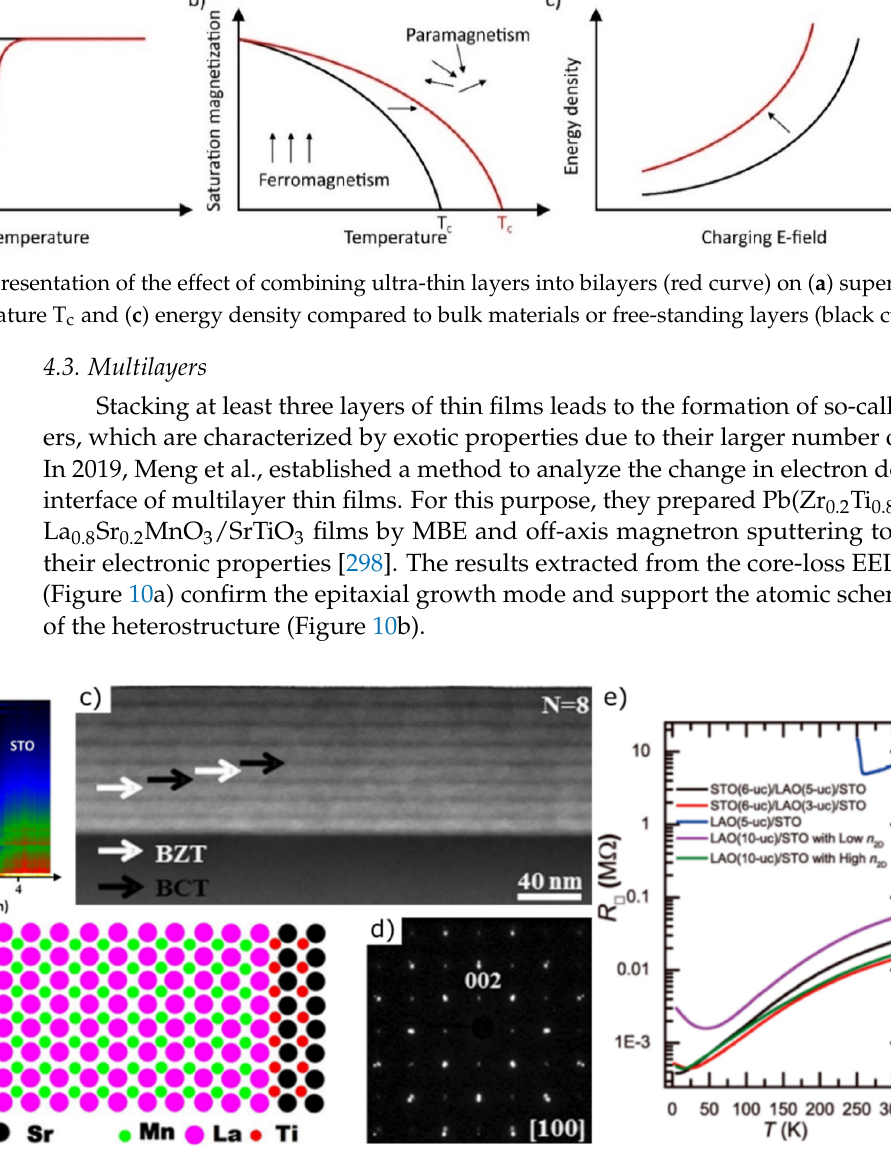
Figure 10. ( a ) Core-loss EELS spectrum image of Ti L, O K, Mn L and La M edge and ( b ) atomic schematic model of a Pb(Zr 0.2 Ti 0.8 )O 3 /La 0.8 Sr 0.2 MnO 3 /SrTiO 3 structure [298]. ( c ) Cross-sectional STEM image and ( d ) SAED pattern of a (Ba 0.7 Ca 0.3 TiO 3 /BaZr 0.2 Ti 0.8 O 3 ) 4 multilayer. Black and white arrows indicate Ba 0.7 Ca 0.3 TiO 3 (BCT) and BaZr 0.2 Ti 0.8 O 3 (BZT), respectively [299]. ( e ) Temperature-dependent sheet resistance R S for LaAlO 3 (5-uc)/SrTiO 3 (100), LaAlO 3 (10- uc)/SrTiO 3 (100), and SrTiO 3 (6-uc)/LaAlO 3 (t-uc)/SrTiO 3 (100). Samples with the SrTiO 3 capped layer show metallic behaviour down to 5 K even with a thickness of only 3 unit cells of the LaAlO 3 layer [242]. Figure 3a reprinted with permission from Singh et al. [242]. Copyright 2021 by the American Physical Society.